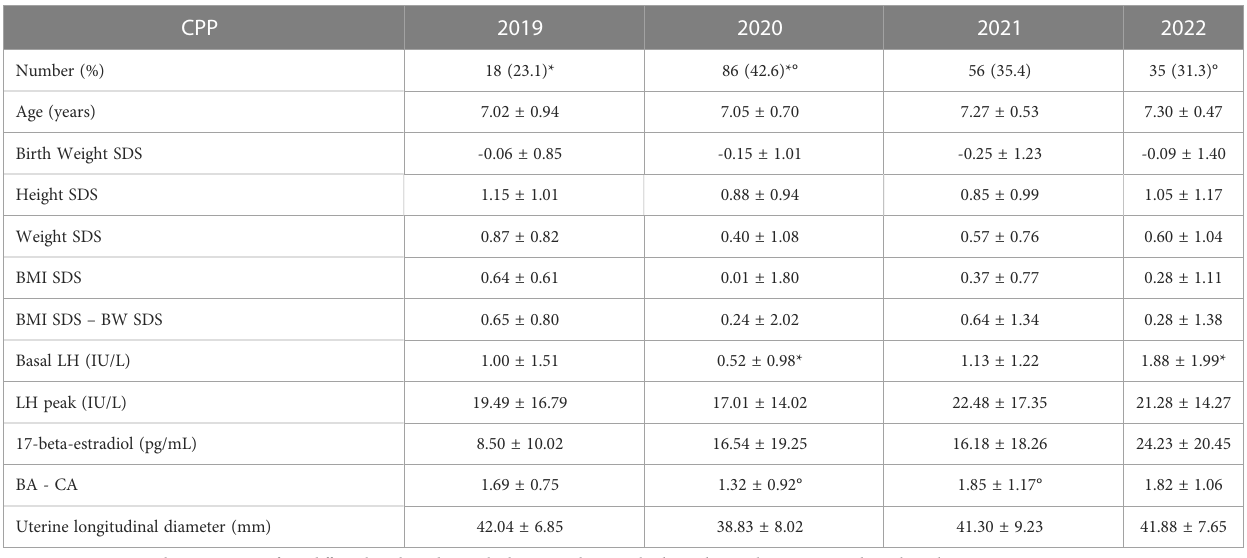
TABLE 3 Anthropometric characteristics and laboratory/instrumental parameter comparing the central precocious puberty (CPP) subgroups in the four different